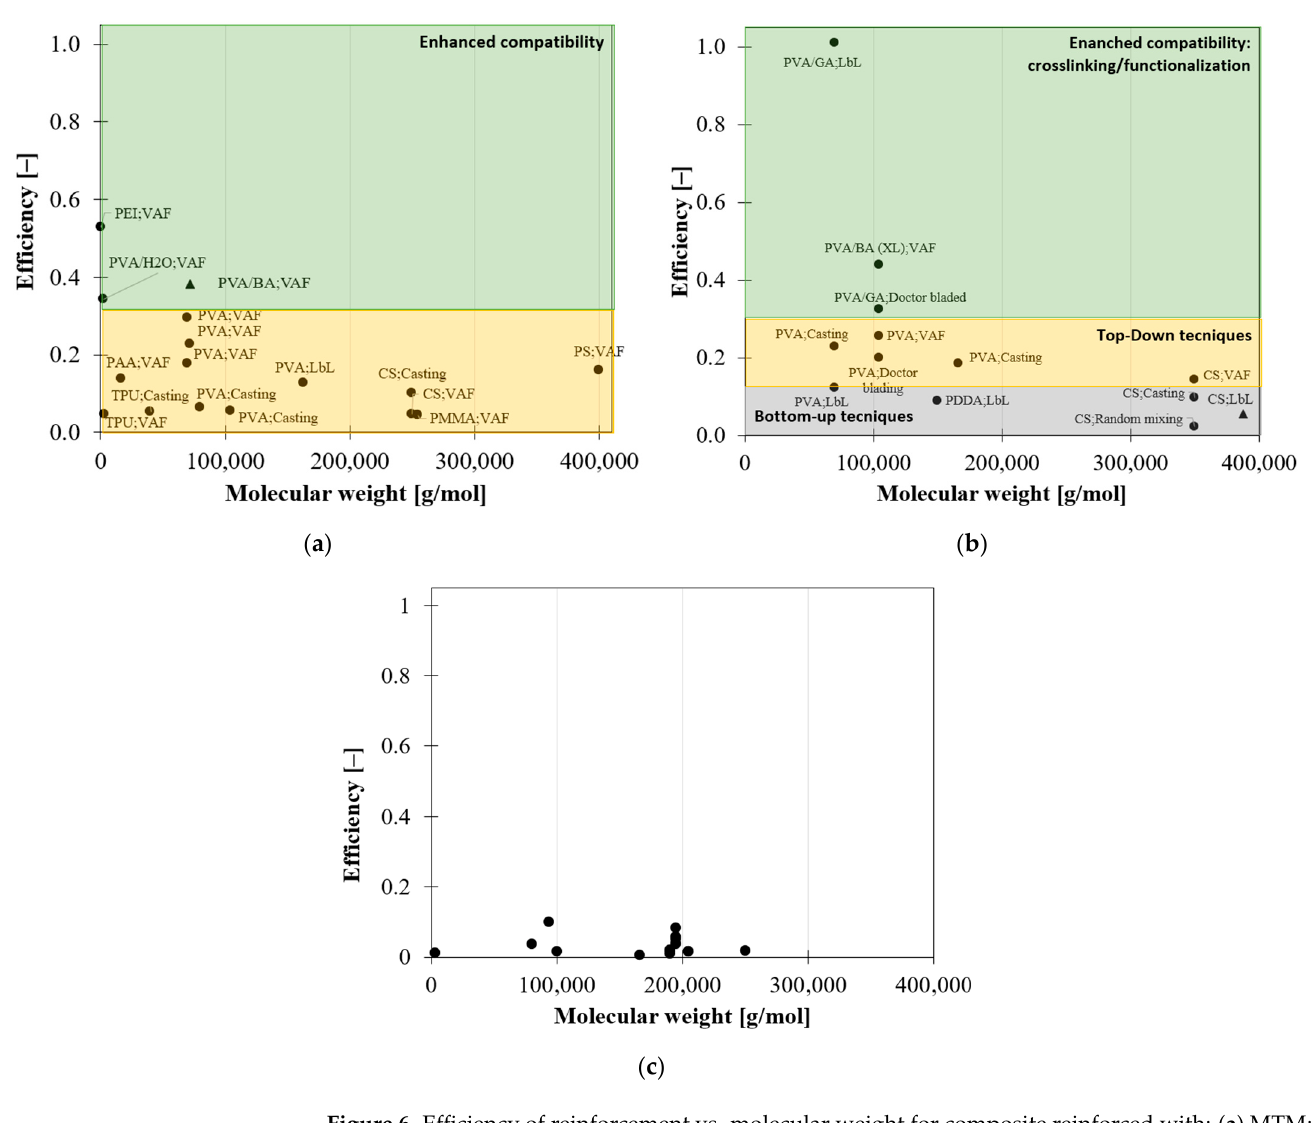
Figure 5. Dependence of drop off point on matrix molecular weight.